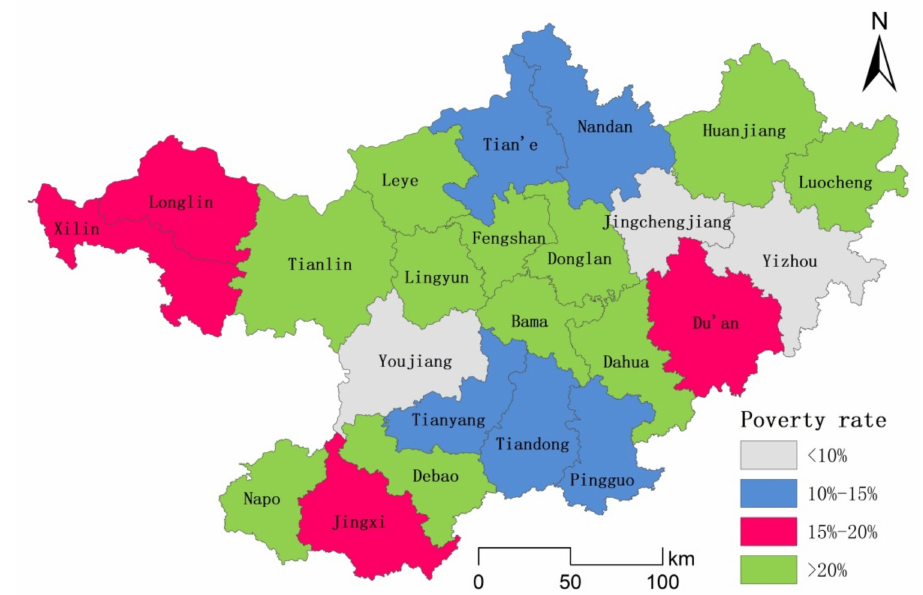
Figure 3. Spatial distribution map of the different types of poverty-stricken counties in northwest